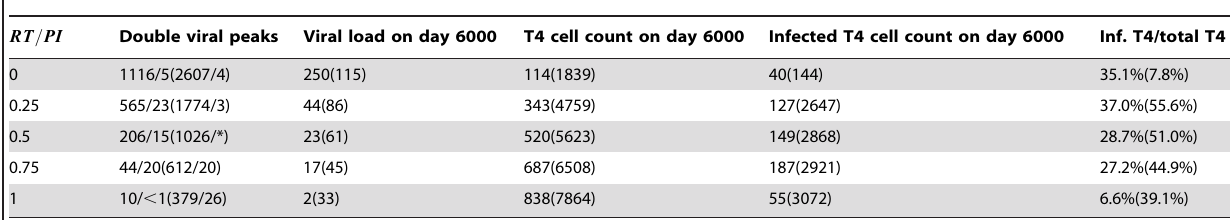
Table 2. Simulation of different levels of drug efficiency.